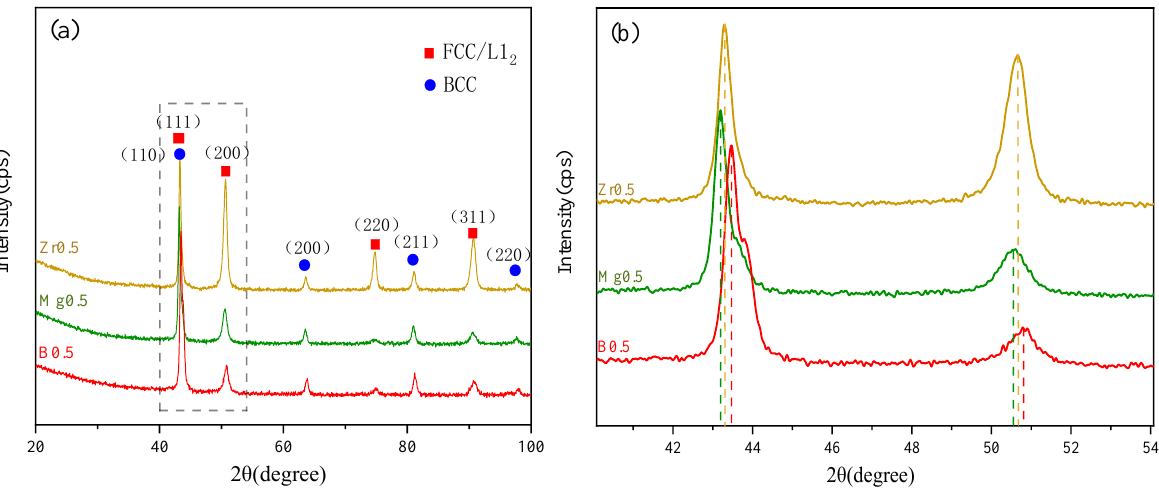
Figure 1. ( a ) X-ray diffraction patterns of the three HEA samples (B0.5, Mg0.5, and Zr0.5) in the as-cast state; ( b ) an enlarged view of the peaks (111) and (200) at 40° to 55° in ( a ).